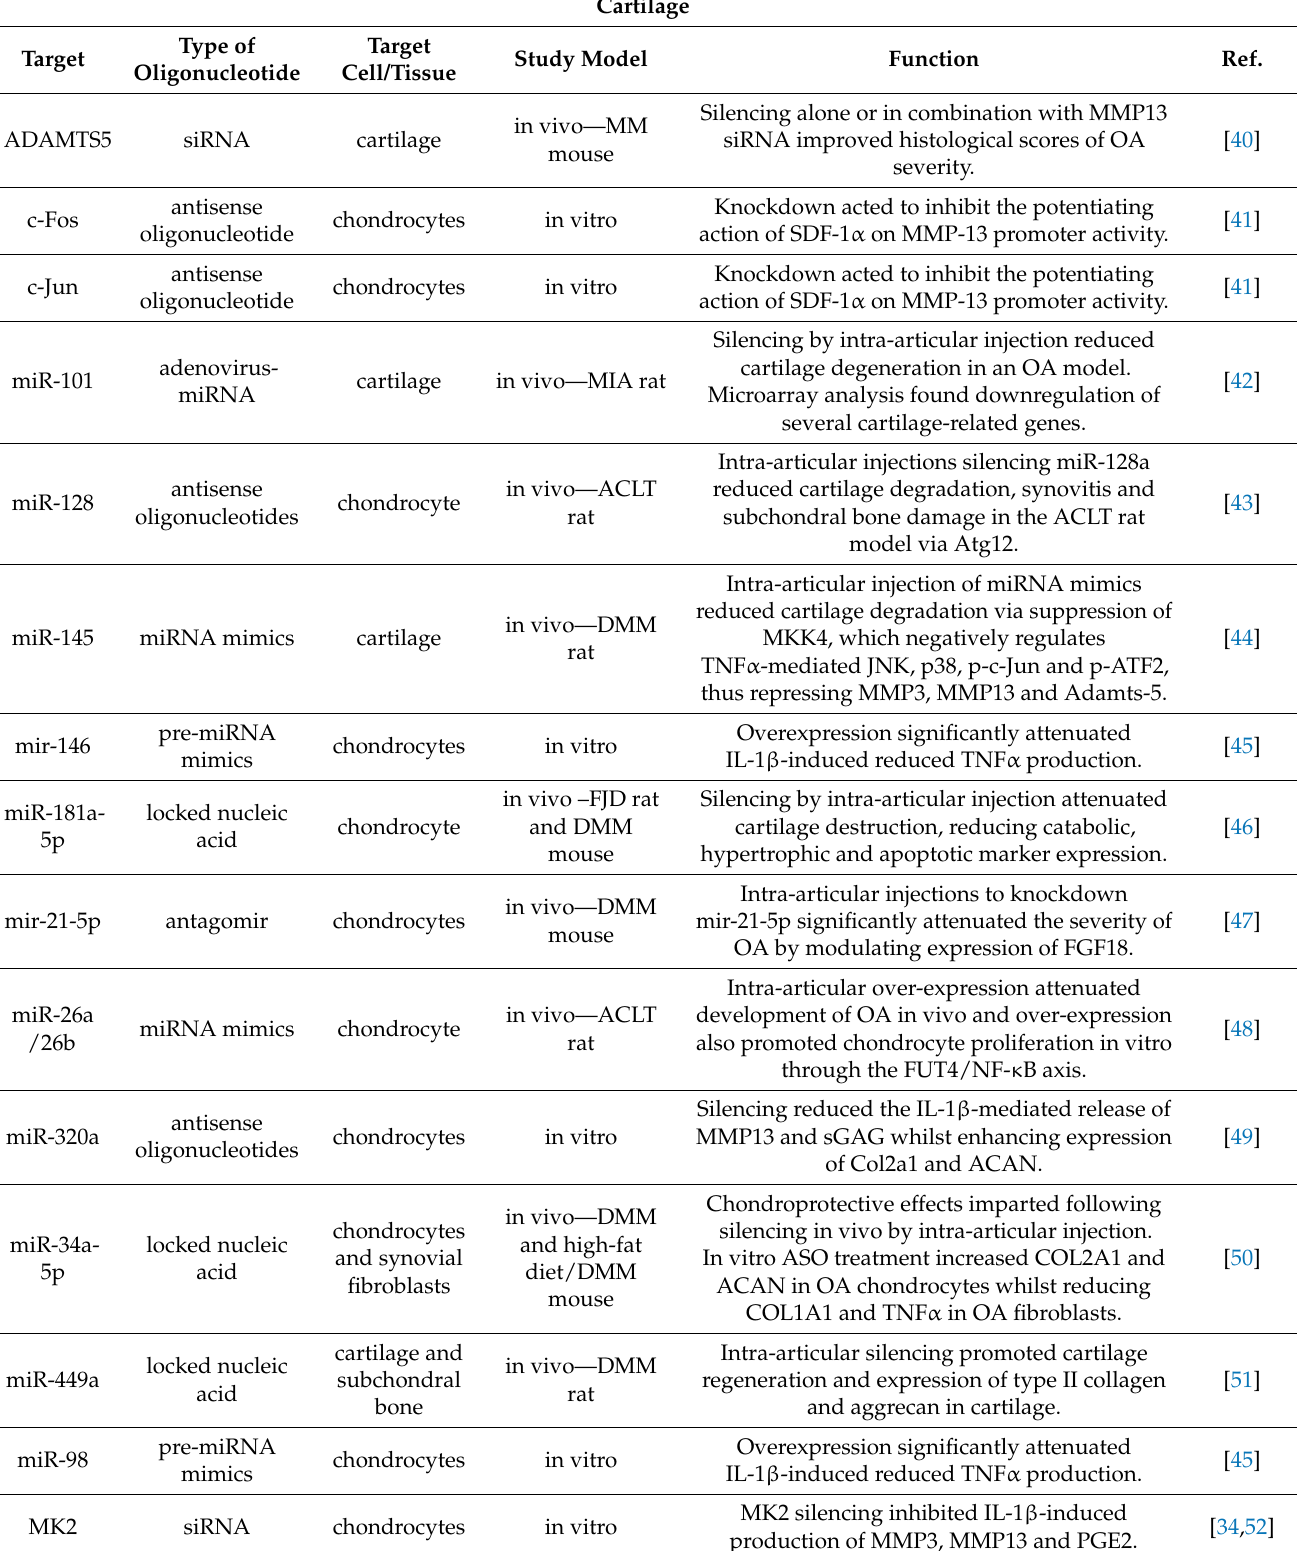
Table 1. Efficacy of oligonucleotides in OA and RA preclinical models.